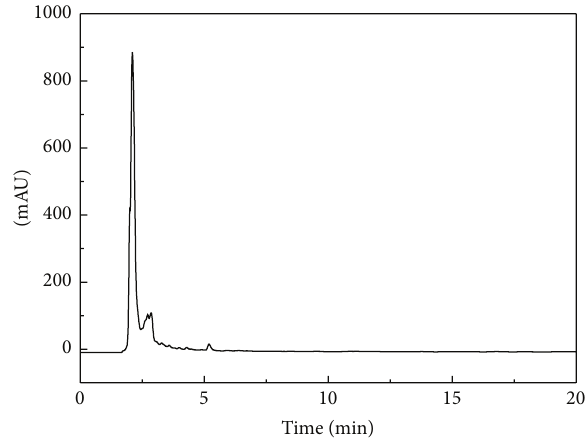
Figure 7: Test group and control group comparison chart fecal homogenates chromatography.